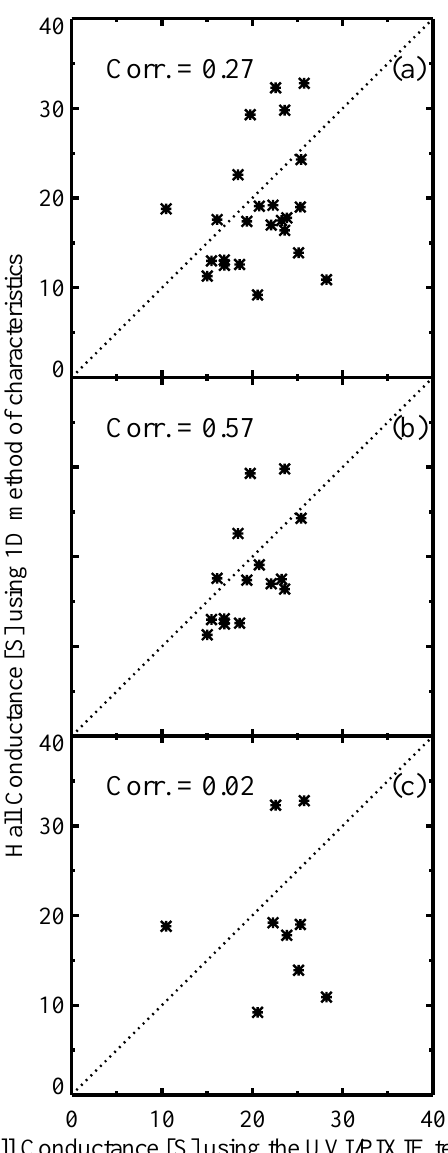
Fig. 12. Hall conductances 6 H derived using the UVI/PIXIE tech- nique (horizontal axis) and the 1-D method of characteristics (ver- tical axis) during ( a ) all conditions (24 data points), ( b ) relatively uniform conditions (15 data points), and ( c ) non-uniform conditions (9 data points). The dotted line having a proportionality factor of 1.0 is drawn to indicate the locations of the Hall conductance values in cases where the two data sets provide the same output.